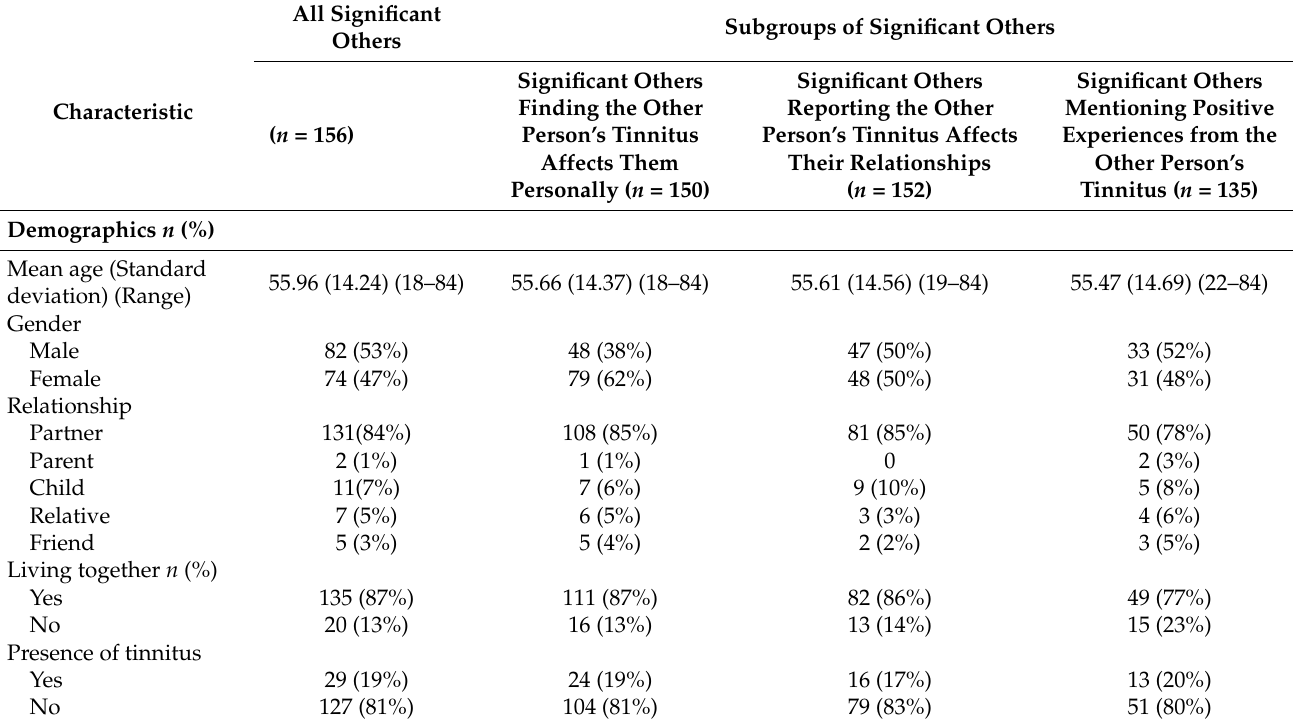
Table 1. Demographic profile of the significant others.